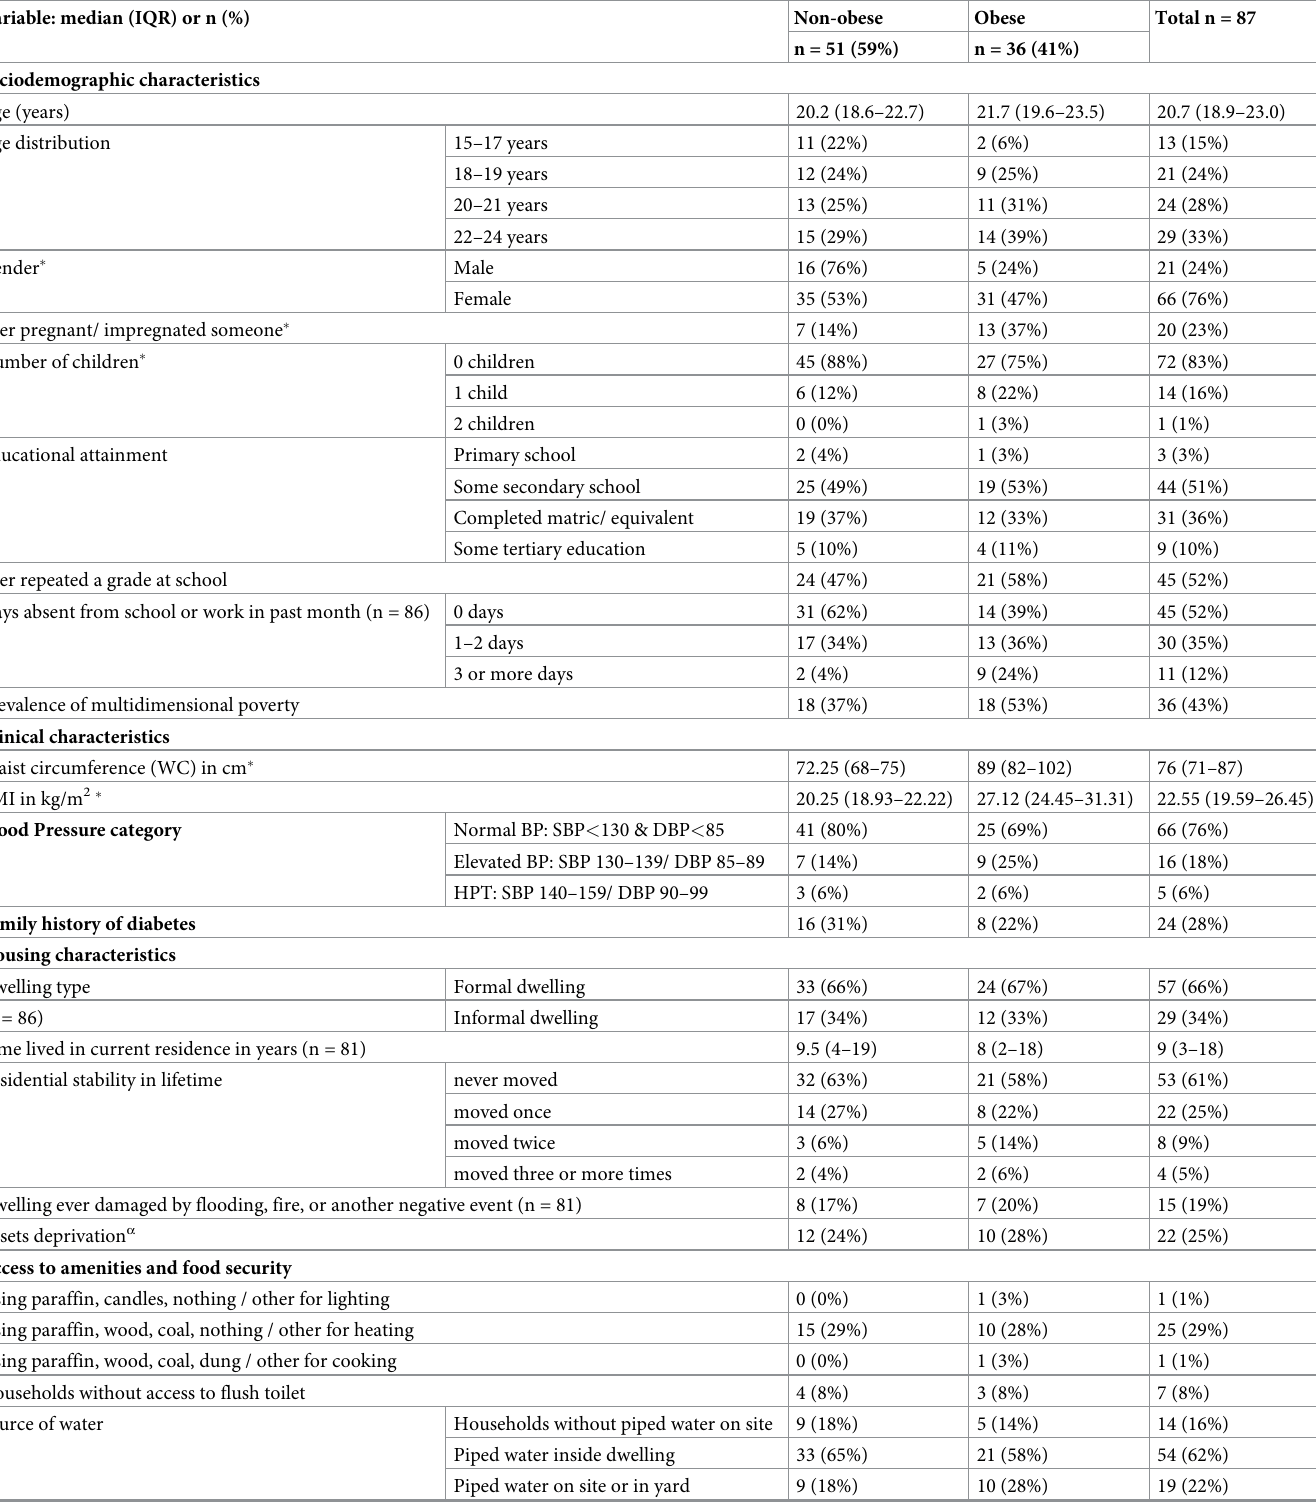
Table 1. Sociodemographic and clinical characteristics of AYLHIV by abdominal obesity